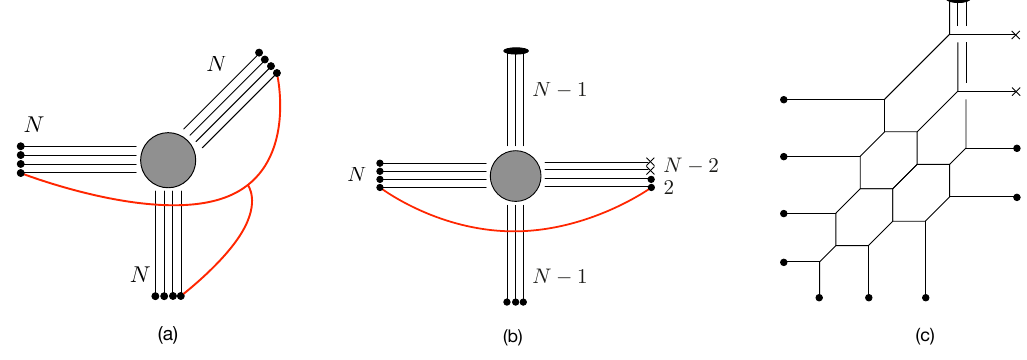
Figure 1. Brane webs for the 5d T N theory, with the string junction/open strings representing the long operators. The non-(cid:13)avor D7-branes are denoted by an \x" rather than by a